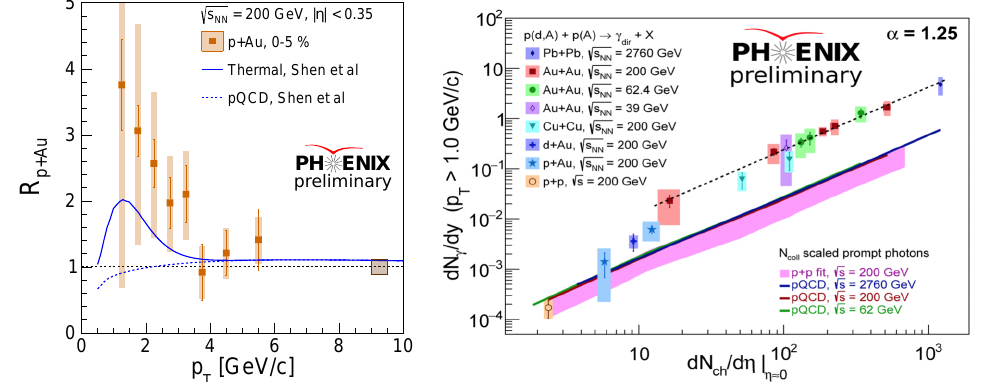
√ s NN = 200 GeV at 0–5 % centrality ( left ). Direct